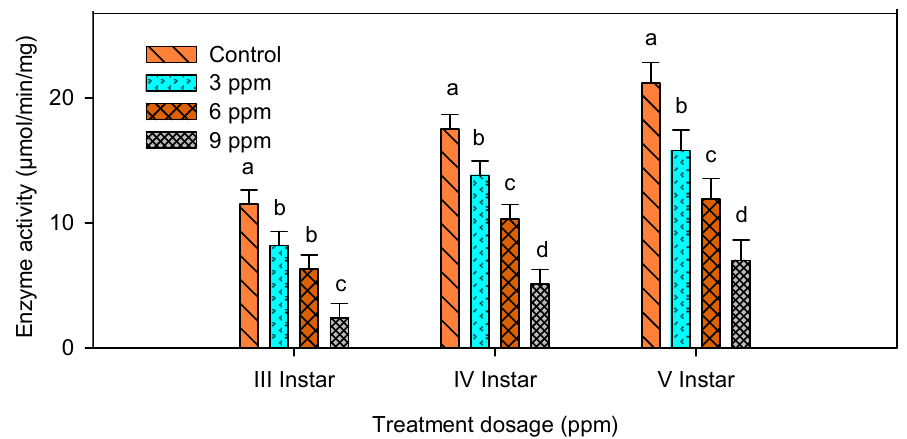
Figure 5. Digestive enzyme protease activity in third, fourth and fifth instar larvae of S. litura after treatment with andrographolide. The data’s were fitted on polynomial (regression) model, Means (± standard error (SEM)) followed by the same letters above bars indicate no significant difference ( p < 0.05) in a Tukey’s test.